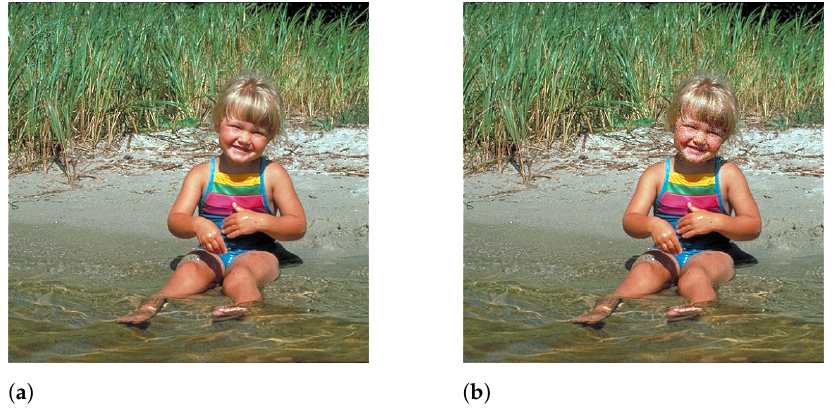
Figure 1. HVS’s perception of local image quality in relation to visual saliency: ( a ) degradation in non-salient region, ( b ) degradation in salient